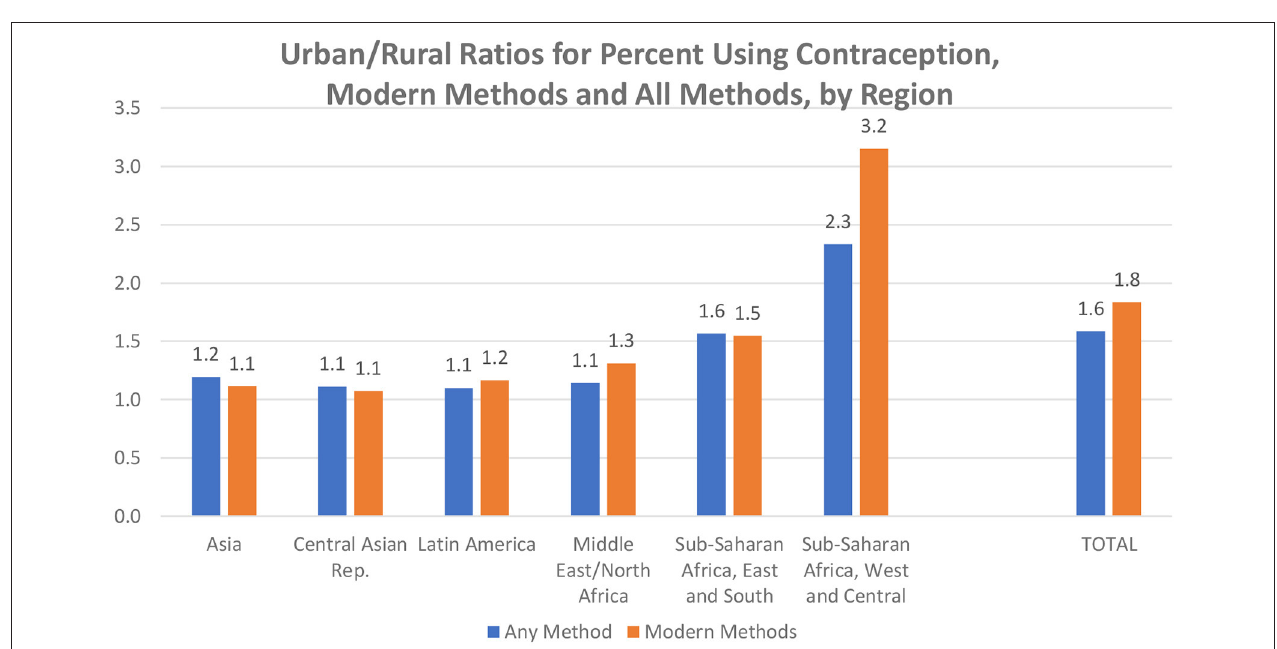
FIGURE 2 | Urban/rural ratios for percent using contraception, modern methods and all methods, by region.